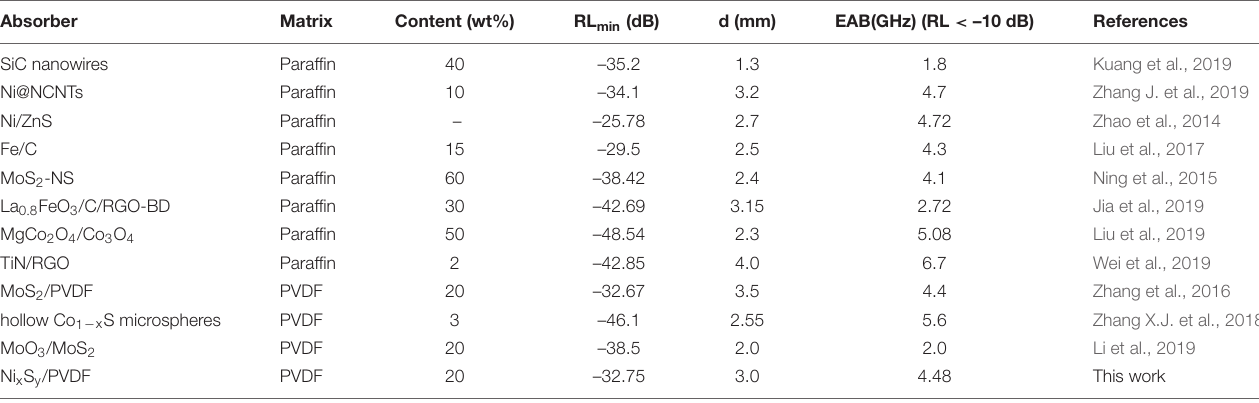
TABLE 1 | Electromagnetic wave absorption properties of various composite materials including transition metal compound nanomaterials in previous reports compared with this